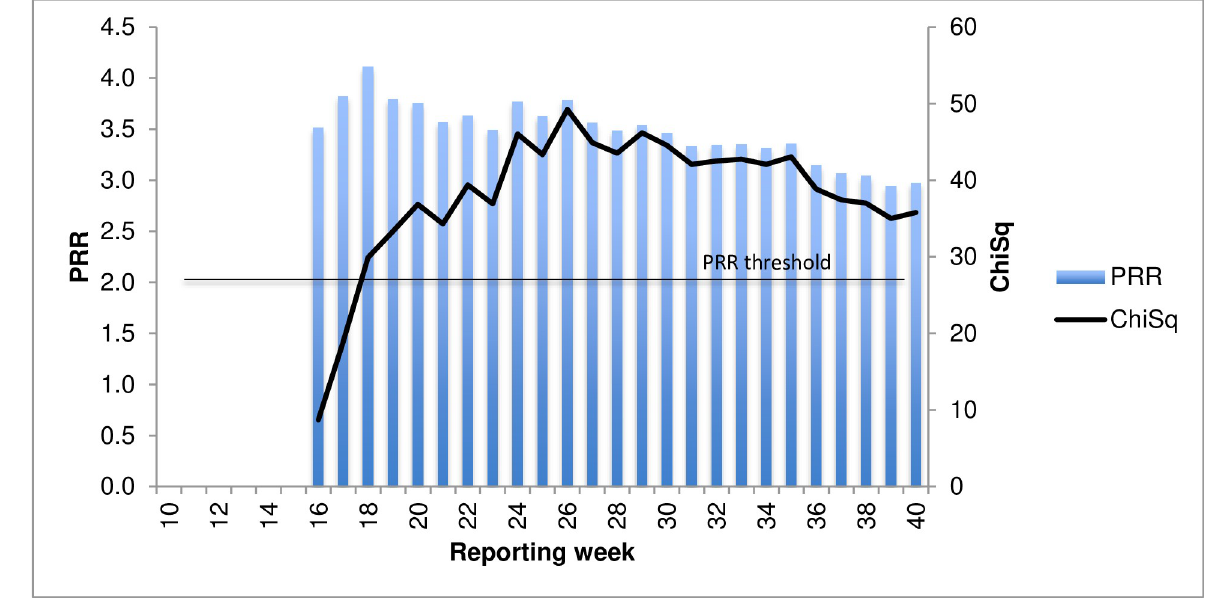
Fig 8. PRR cumulative and ChiSq for influenza vaccines and allergic reactions by reporting week,